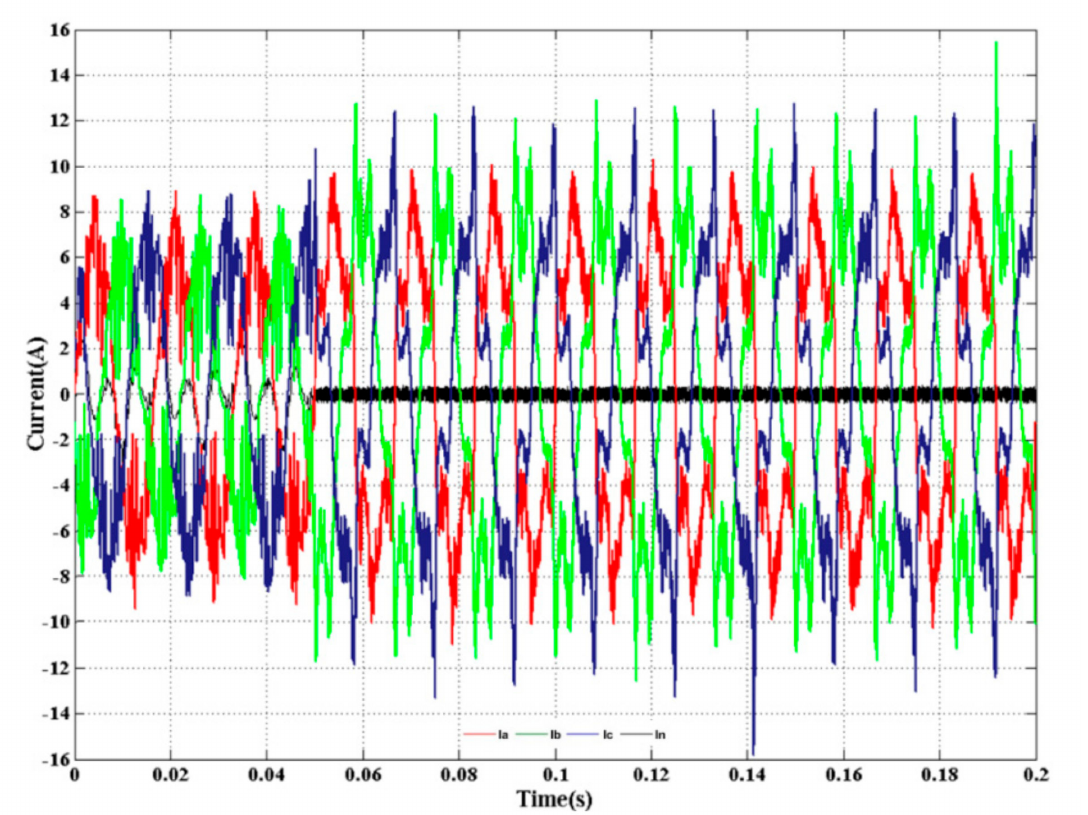
Figure 18. Experimental result of the sliding DFT for case